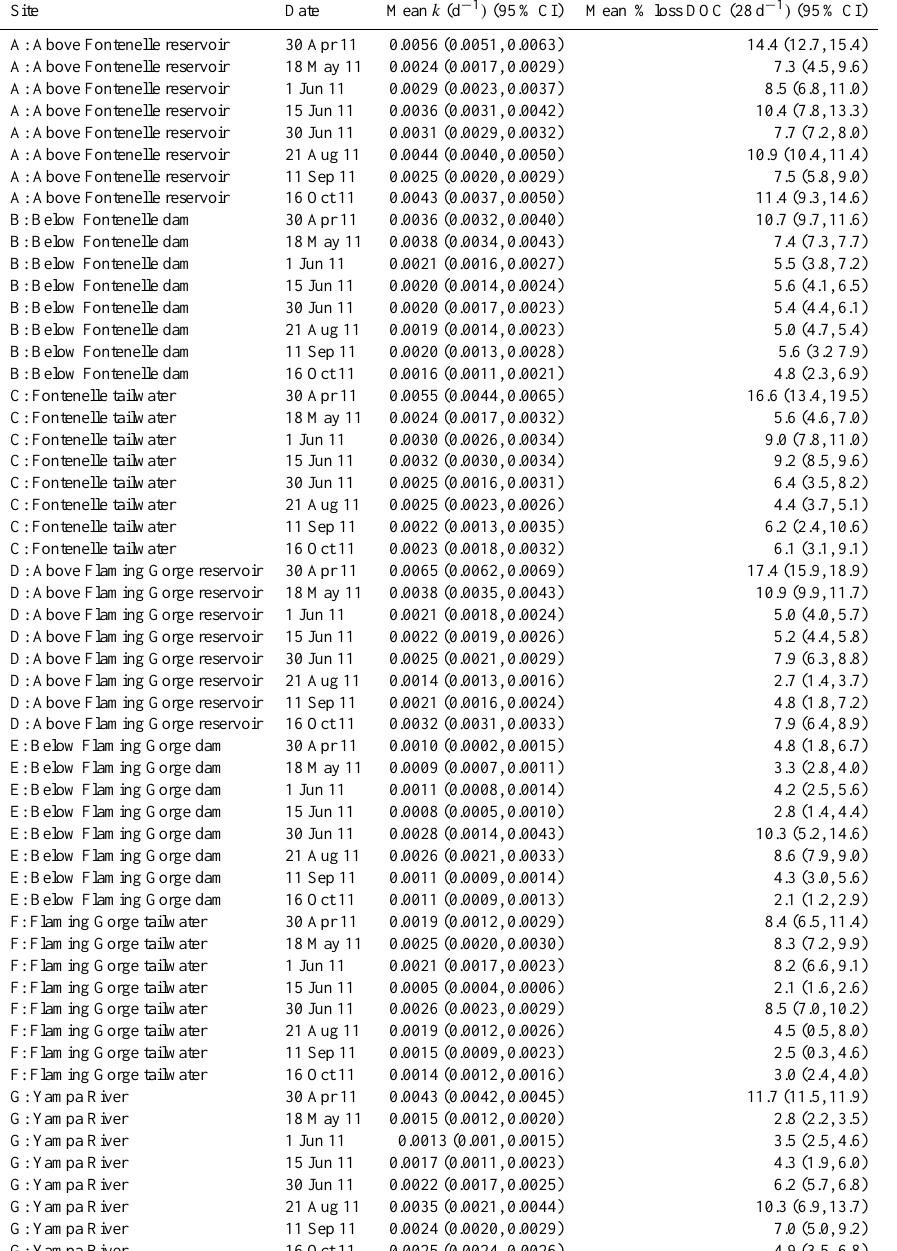
Table B1. Mean decay rates ( k , d − 1 ) and mean percentage (%) loss of DOC over 28-day bioassay experiment. Mean percentage loss was calculated by dividing the difference in DOC concentration (mgL − 1 ) from day 0 to day 28 by the initial DOC concentration at day 0 and then multiplying by 100. The 95% confidence intervals were calculated for k d − 1 and % loss of DOC from three replicate bioassay experiments for each site and each date. Letters A–G preceding the site names correspond to sites A–G in Fig.